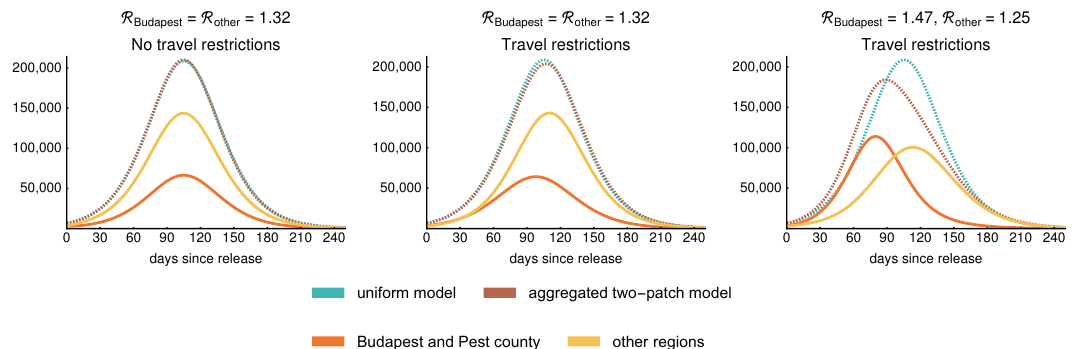
Figure 13. Epidemic curves of the regions: sum of the infective compartments ( I p , I ) . First, we consider identical reproduction numbers R = 1.32 a , 1 , I a , 2 , I a , 3 , I s , 1 , I s , 2 , I s , 3